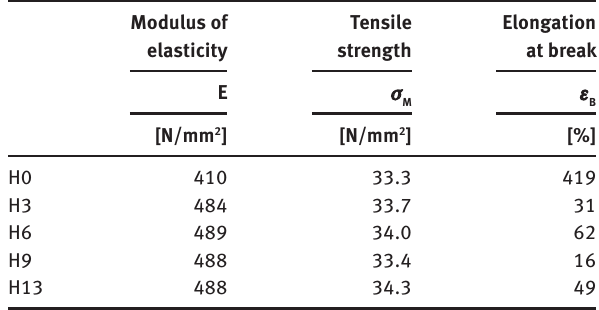
Table 3: Mechanical properties of PP and the PP/LDH